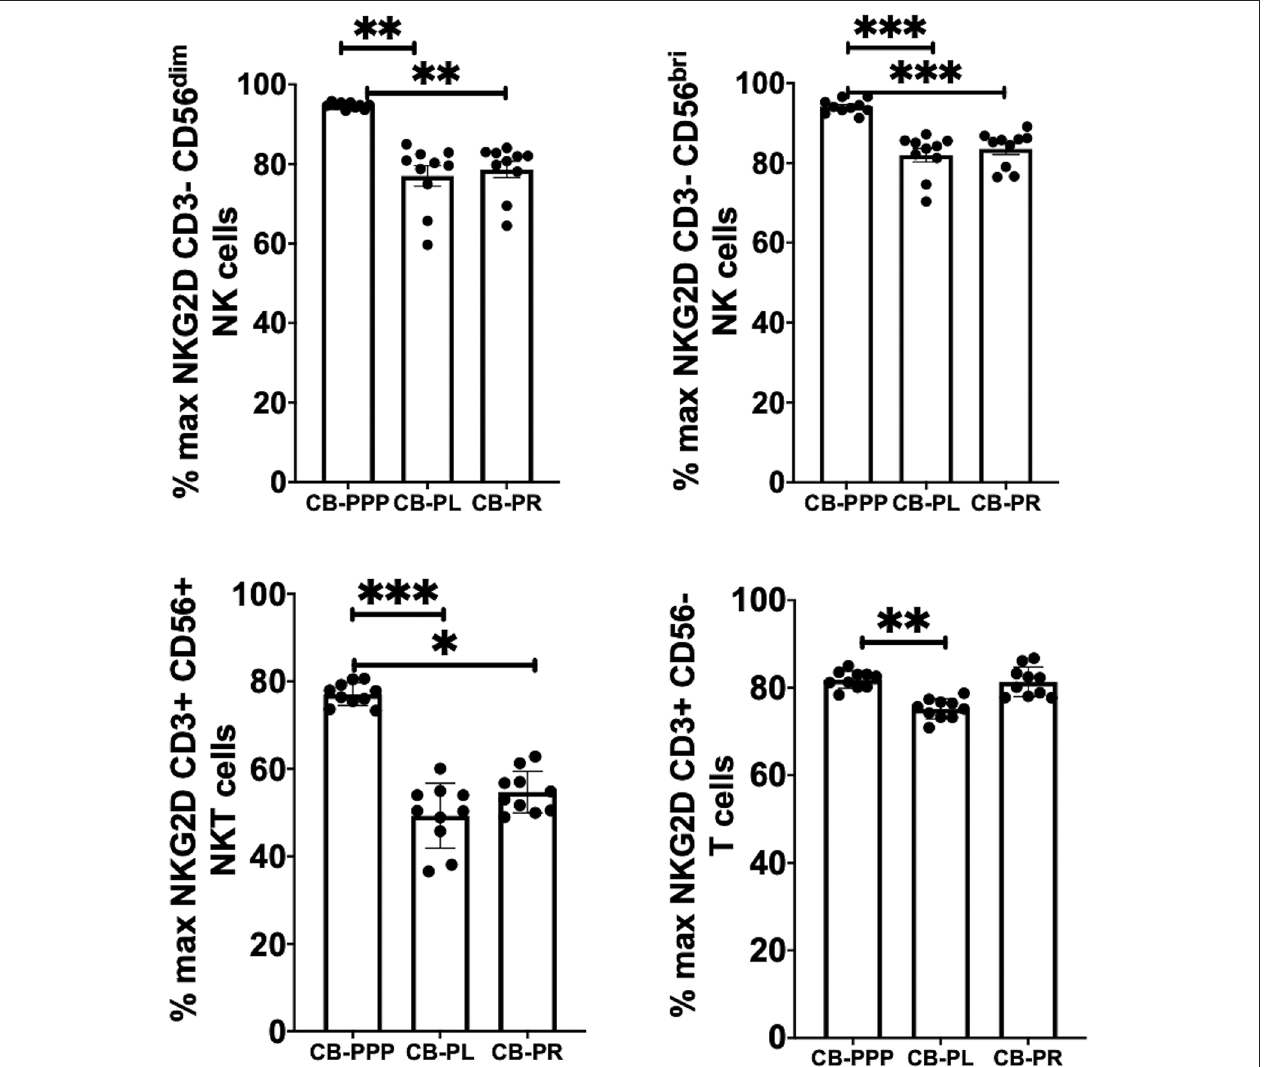
FIGURE 4 | Expression of NKG2D on NK, NKT and T cells from healthy donors is reduced by incubation with, CB-PPP, CB-PL, and CB-PR. Data represents analysis of CD3– CD56 dim, CD3– CD56 bright NK cells, CD3 + CD56 + NKT cells and CD3 + CD56– T cells in adult donor PBMCs ( n = 4) after incubation with CB-PRP preparations or complete media only. Results show percentage of maximum expression relative to complete media for each cell type from unstimulated cultures. CB-PRP preparations investigated were cord blood platelet poor plasma (CB-PPP; n = 10), cord blood platelet lysate (CB-PL; n = 10), or cord blood platelet releasate (CB-PR; n = 10). PBMCs were incubated with each preparation diluted 50:50 with media and supplemented with IL-2, or with complete media and IL-2 only for 48h prior to antibody staining and flow cytometry analysis. Each experiment was repeated with four different PBMC donors and data points represent donor means. Statistical analysis was performed using non-parametric one-way ANOVA (Kruskal-Wallis test with Dunn’s post-hoc test for unpaired samples and Friedman’s for paired samples). * p < 0.05, ** p < 0.01, *** p <